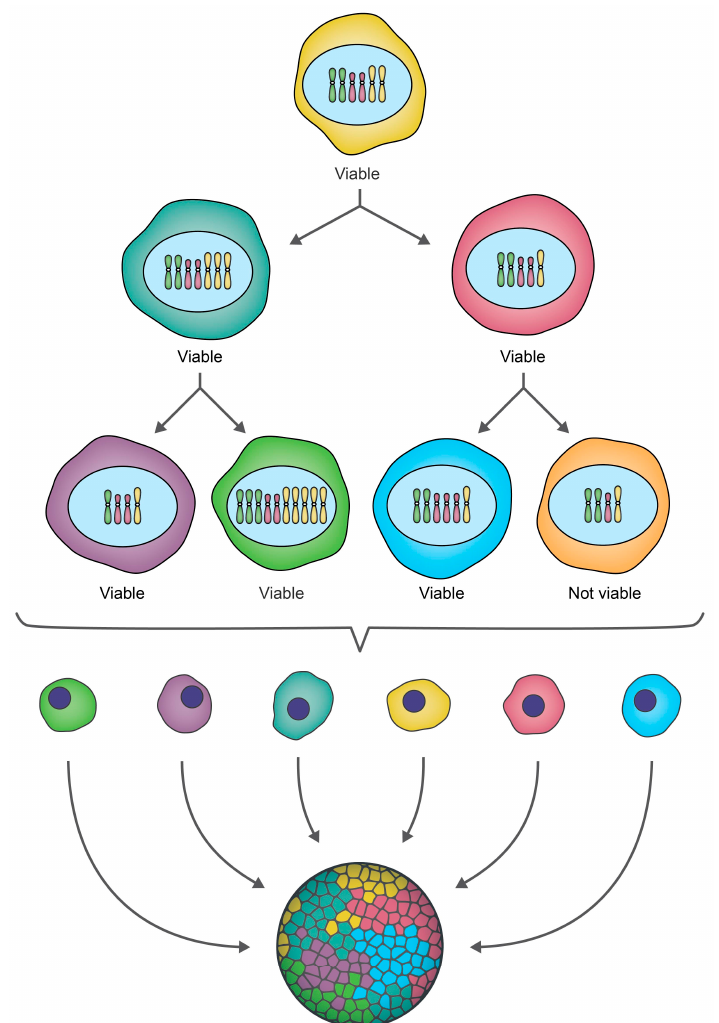
Figure 2. CIN drives ongoing karyotypic heterogeneity within cellular populations. A schematic depicting a hypothetical example of CIN within an initial cell that for illustrative purposes contains only three pairs of chromosomes (i.e., a partial karyotype). As this cell undergoes two rounds of cellular division, chromosomes are gained or lost, producing a heterogeneous population of genetically distinct daughter cells, which is referred to as intratumoral heterogeneity in a cancer context. Some karyotypic changes may not be compatible with cell viability, as indicated by the orange cell which is lost from the population. Note that while this example focuses on small-scale gains/losses of whole chromosomes (N-CIN), chromosome complements may also evolve via increases in ploidy (N-CIN) or structural chromosome changes (S-CIN) (see Figure 1), and often include a combination of both N- and